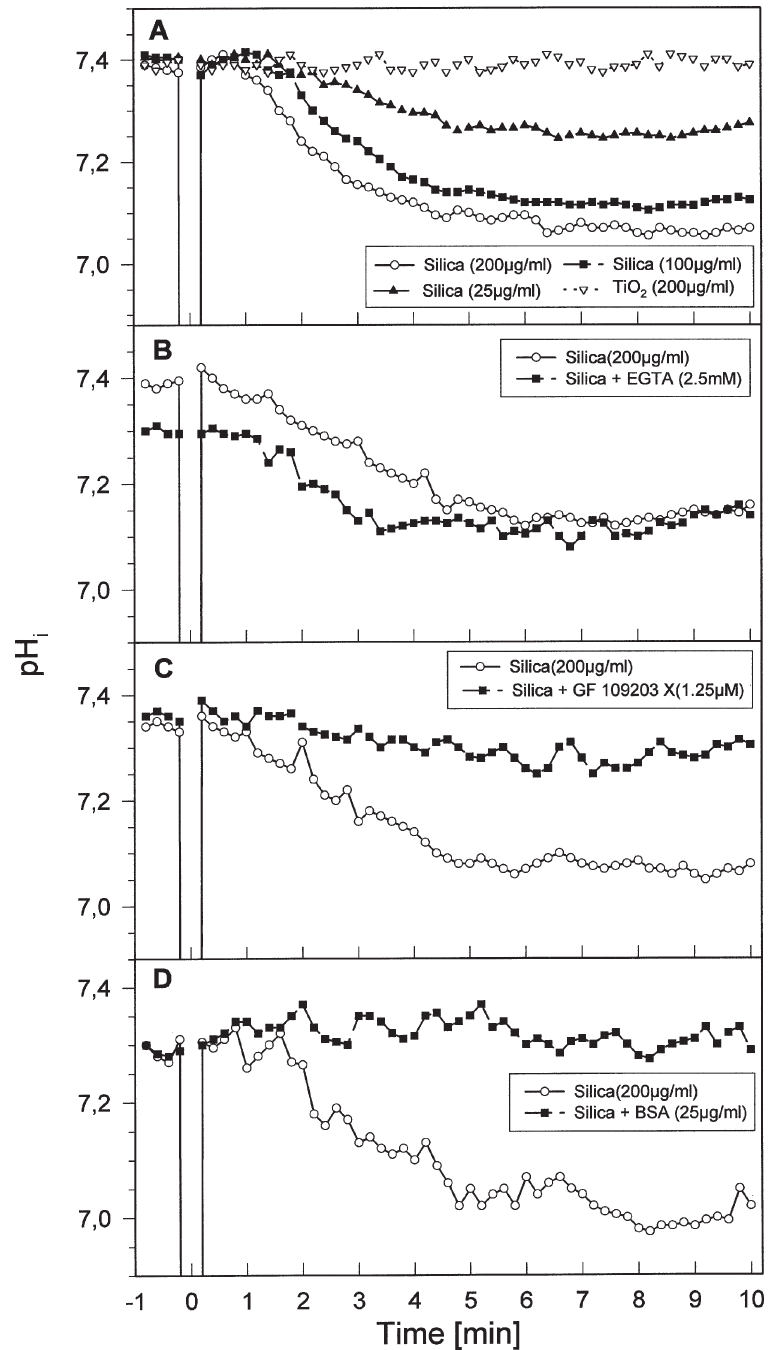
Fig. 3. Kinetics of pH i after stimulation of BAM with silica (QUSO G 32) or TiO 2 (A), silica with or without preincubation EGTA (B), GF 109203 X (C), and with untreated or BSA-coated silica (D). Data show tracings of single runs and are representative for at least 6 experiments. Experimental details as in Fig.